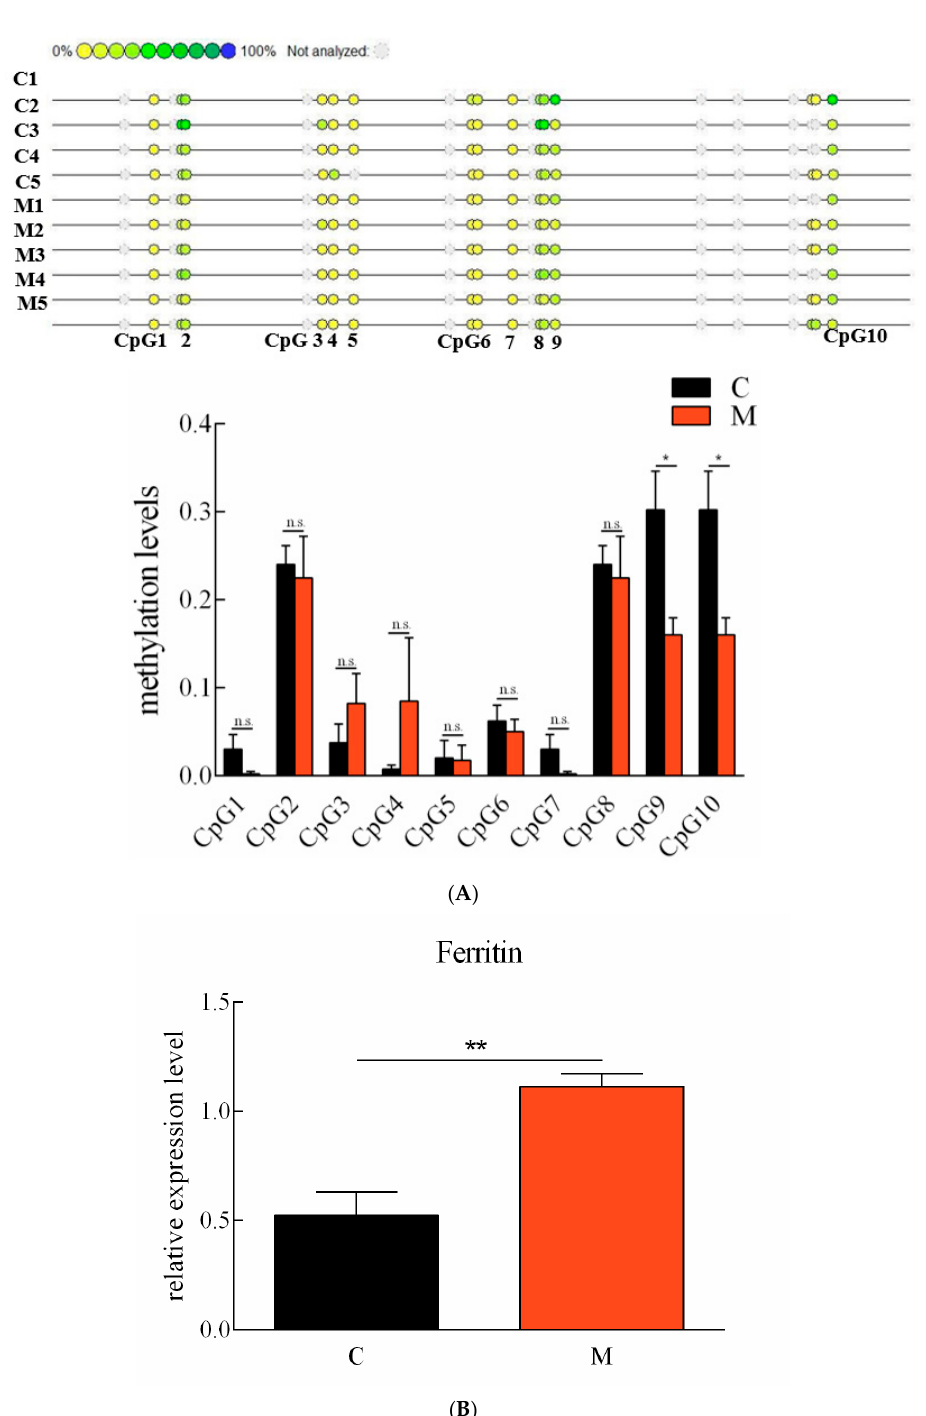
Figure 7. Methylation levels of “CpG” loci and mRNA expression levels of Ciferritin in grass carp individuals of different resistance. ( A ) Ferritin promoter “CpG” loci methylation levels, and ( B ) mRNA expression level comparison in the progeny of ordinary and maternal immunized grass carp. An asterisk (*) denotes a significant differences ( p < 0.05), ** indicates p < 0.01, and n.s indicates no signif- icant difference ( p > 0.05). Letter C indicates progeny from ordinary grass carp, and M represents progeny from maternal immunized grass